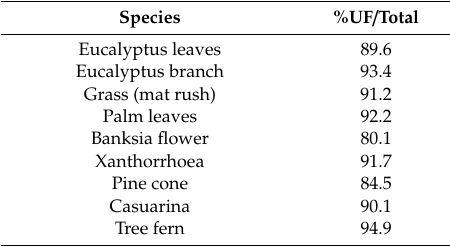
Table 2. Percentage of fine particle number in total smoke particles for each